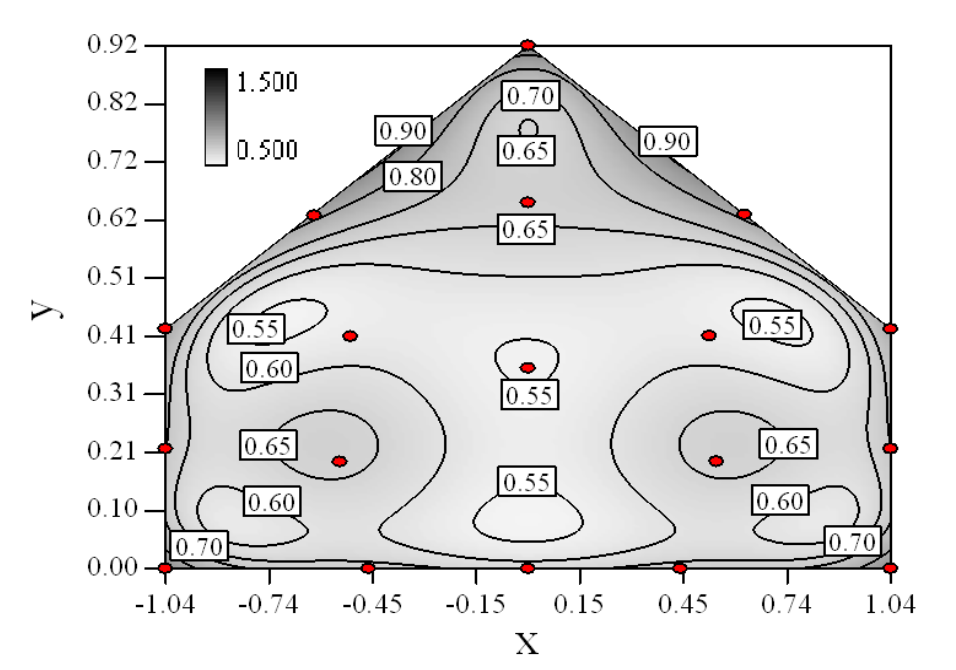
Figure 2. Distribution of standard deviation error as a third-order response surface from the selected sampling positions designed by IV optimal design. The minimum detectable change in the response is 0.15, mean experimental error is 0.087, and significant level is 0.05. Within the design space, 94% section of region area is lower than the surface-averaged standard error, which is equal to